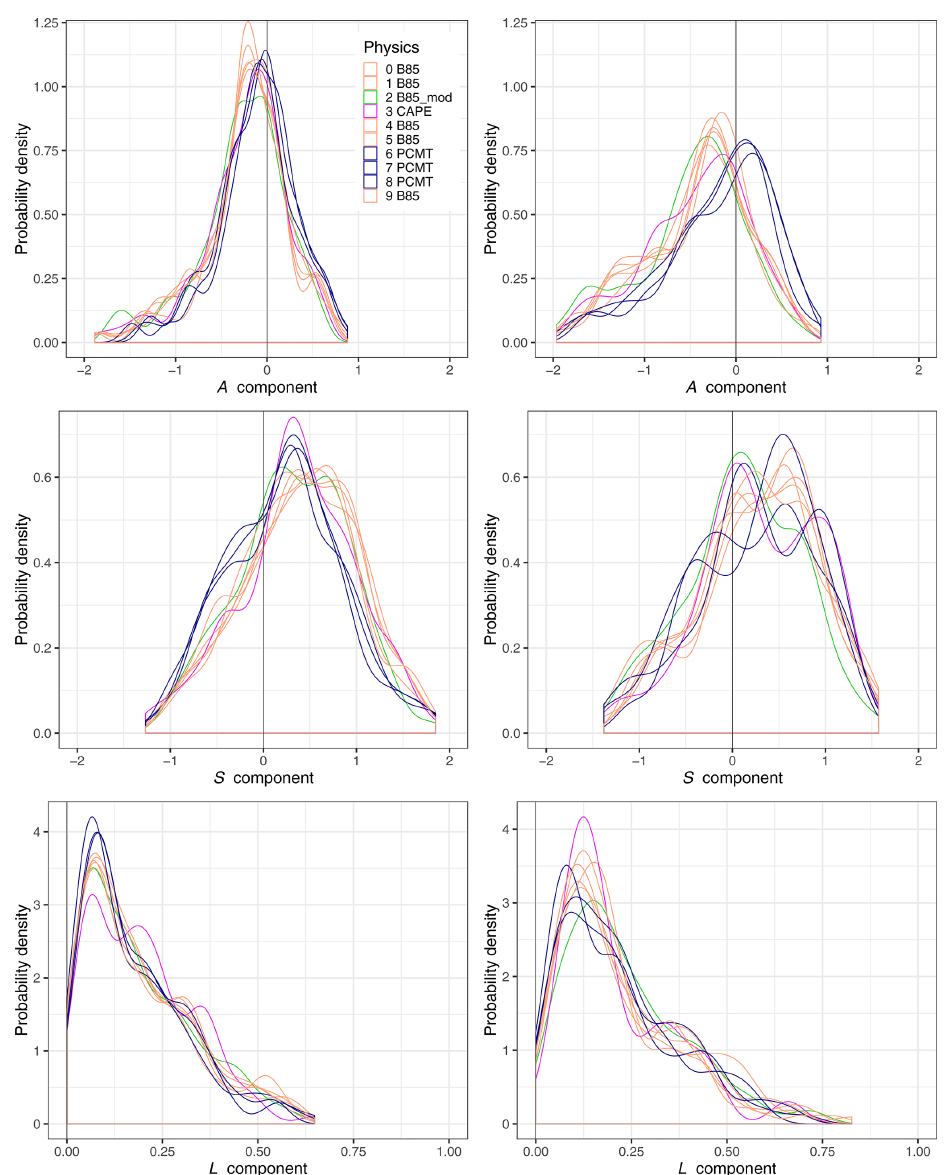
Figure 8. Probability density functions of the three SAL components for the HPEs and for each physics of the reforecast system (coloured lines). Physics scheme are gathered in four categories depending on the parametrization of the deep convection: PCMT (blue), B85 (orange), B85 mod (green), and CAPE (purple). The left column corresponds to lead time LT12, and the right column relates to lead time